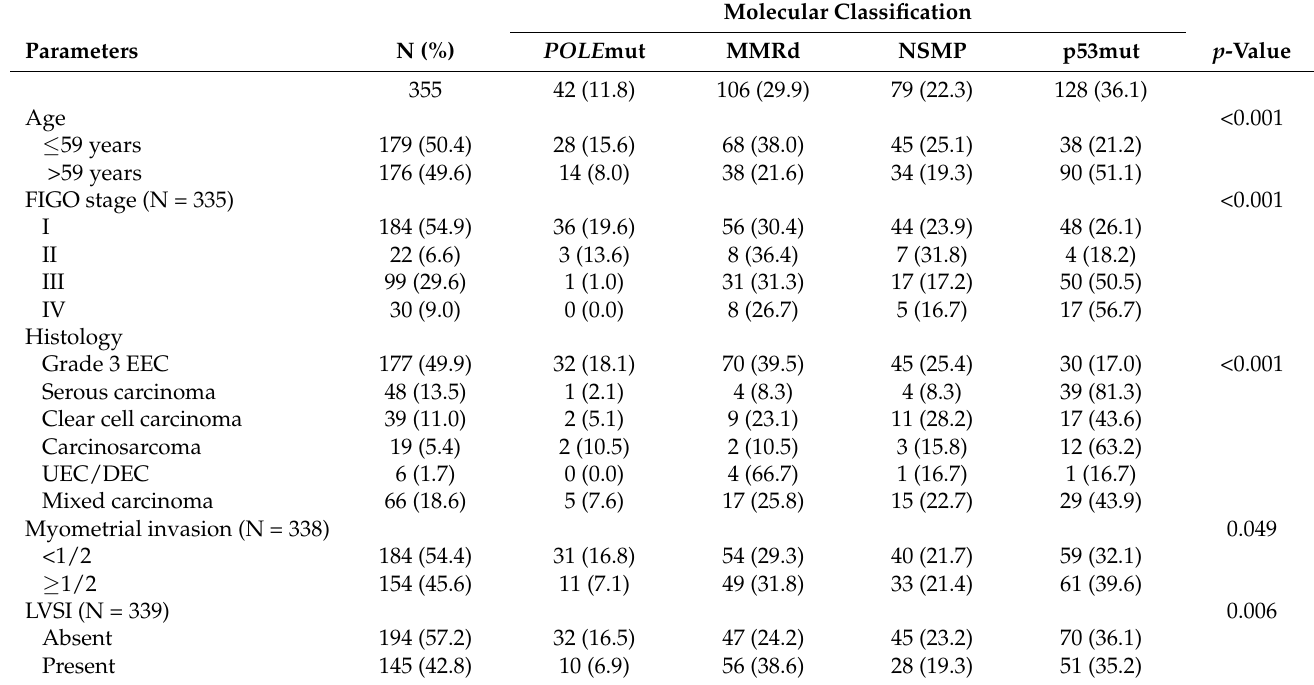
Table 1. Molecular classification of patients with high-grade endometrial carcinoma (N = 355) distributed according to their clinicopathological parameters. Molecular